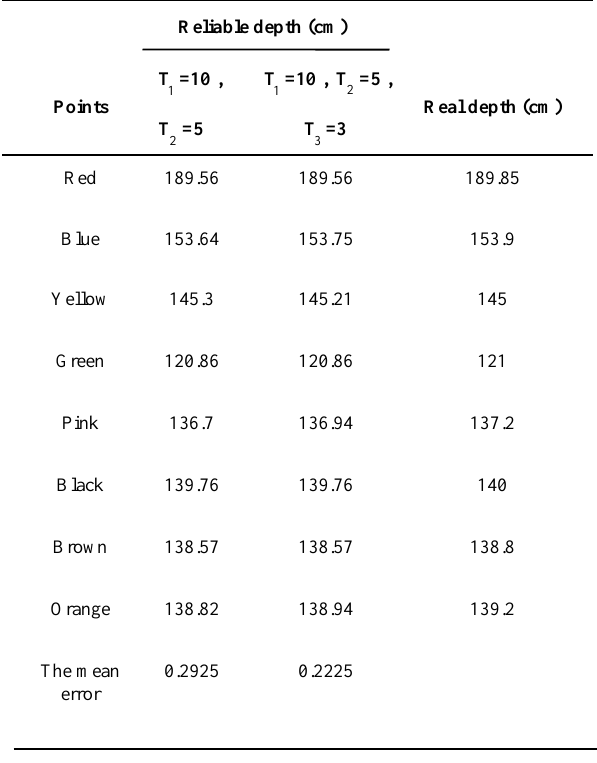
Table 2. Reliable depth value using the gradual omission of outliers method for "Collection".